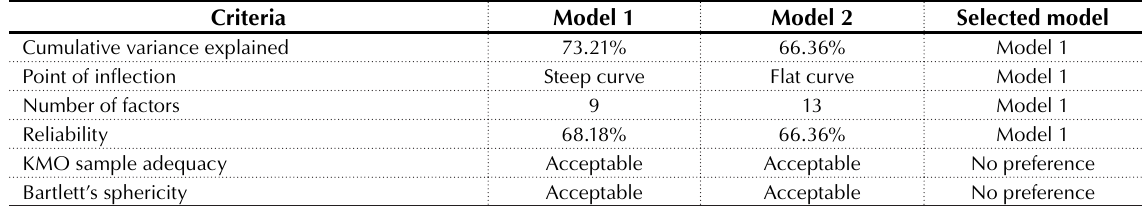
Table 6. Summary of comparative